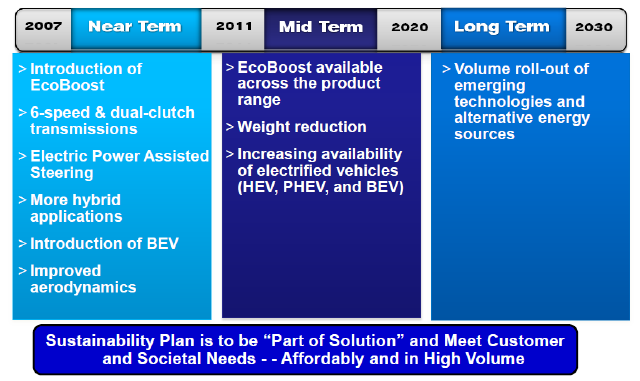
Figure 3. Transforming the CO 2 emission target into product plan. Source [34].